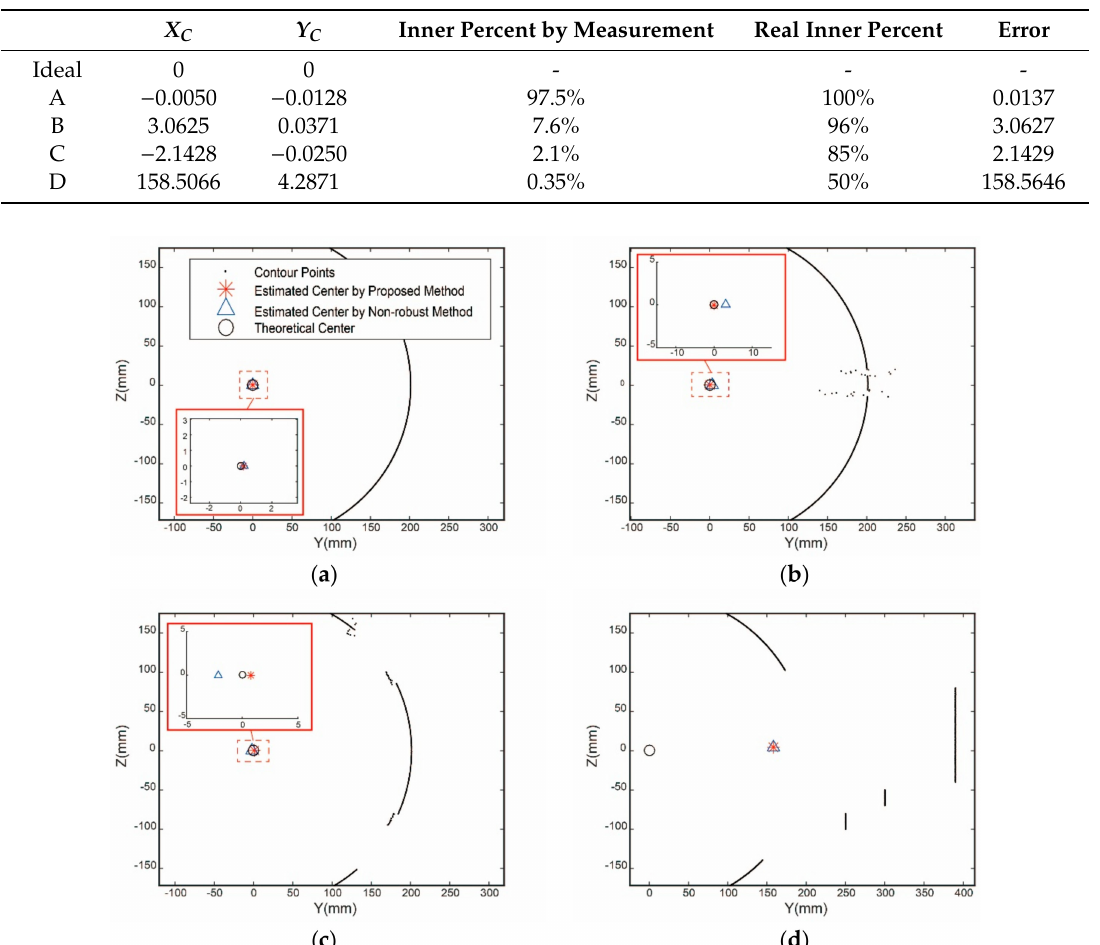
Figure 6. Constructed profile data: ( a ) constructed profile of area A; ( b ) constructed profile of area B; ( c ) constructed profile of area C; ( d ) constructed profile of area